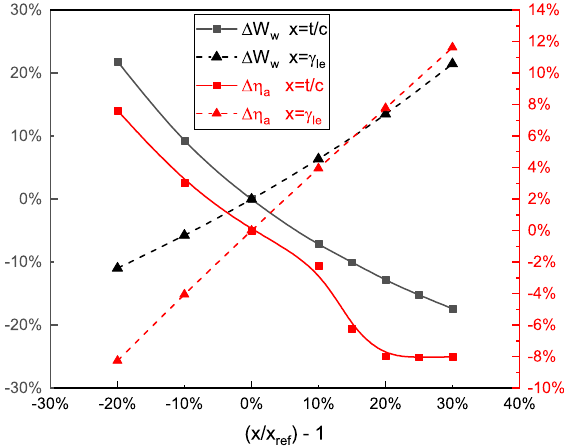
Figure 12. Influence of t/c and γ le on W w and η a , for a forward-swept wing. In particular, a higher t / c makes the optimised wing lighter, whereas higher sweep increases the W w . The aileron effectiveness has benefits on the increment of γ le , in fact, as seen in Section 3.4.2, the forward-swept case has more benefits in satisfying roll require- ments and the consequential increment of the negative angle increments the benefit. An opposite trend is shown for thickness augmentation; in fact, the bigger section is affecting the aeroelastic deformation negatively via partially reducing the aileron effectiveness. A plateau is spotted for higher t / c ; hence, to confirm this behaviour, two more design points are investigated, at t / c = + 15, 20%, and a B-spline curve fitting is used to take into account its variation, while approaching the plateau. It is noticeable that for the forward-swept wing, variations of η a are higher in absolute values with respect to the